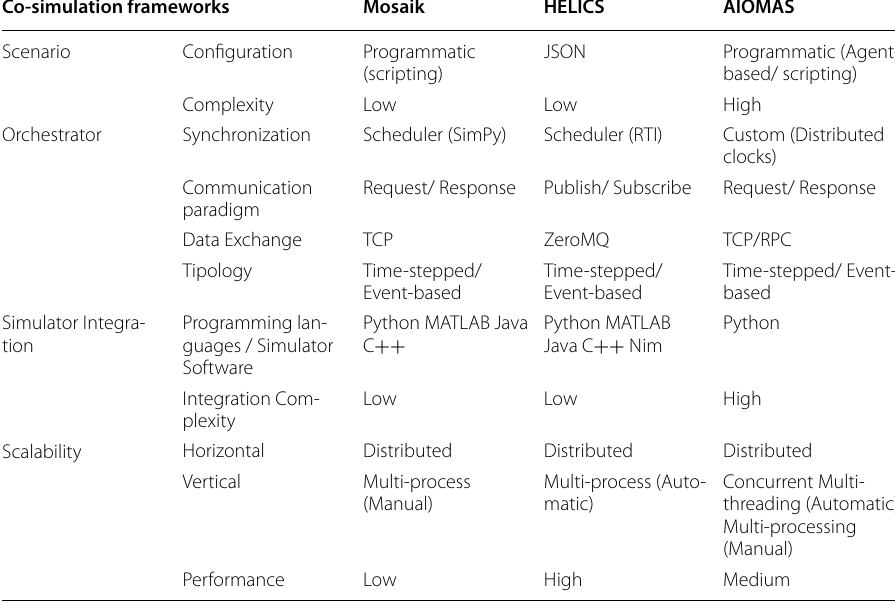
Table 3 Qualitative comparison among Mosaik, HELICS, and AIOMAS Co-simulation